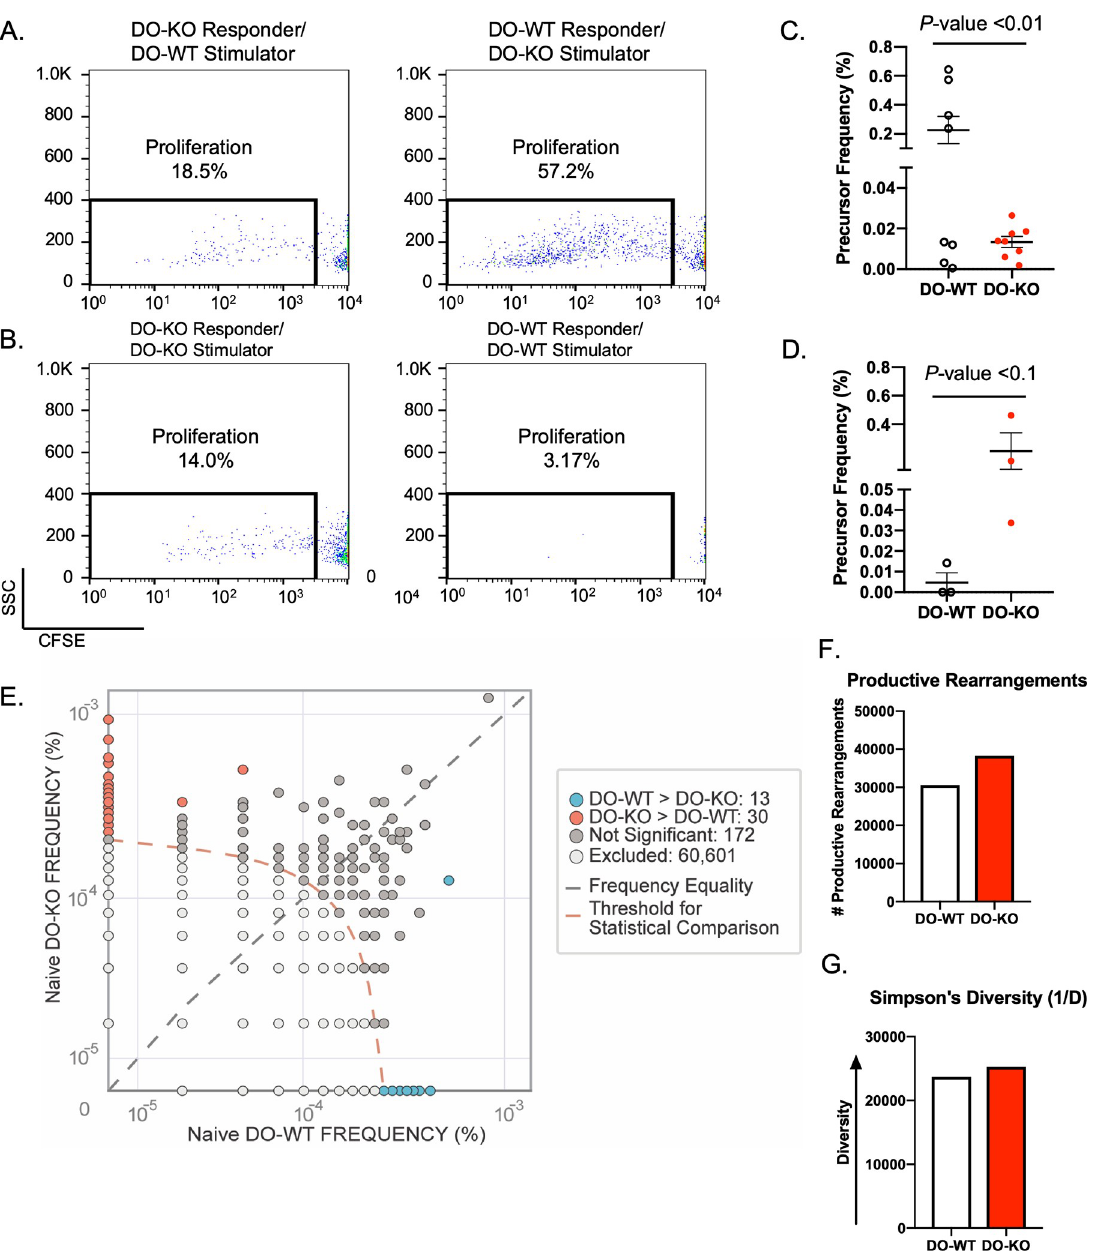
Fig 3. Na ï ve DO-KO mice have a wider T-cell repertoire and are autoreactive. (A) Representative flow plots showing the proliferation of responder CD4 + T cells after stimulation by heterologous B cells. (B) Representative flow plots showing the proliferation of responder CD4 + T cells after stimulation by autologous B cells. (C) PF of responding antigen specific CD4 + T cells in either DO-WT (open) or DO-KO (red) in the modified MLR experiments. N = 8 mice/group (D) PF of responding antigen-specific CD4 + T cells in either DO-WT (open) or DO-KO (red) after autologous B cell stimulation in the modified MLR experiments. N = 3 mice/group. Data are represented as mean ± SEM. (E) TCR β CDR3 sequence comparison of na ï ve CD4 + T cells as determined by next generation sequencing. Dot plot shows the number of TCR β chain sequences that were highly abundant ( > 10 copies/sample, P value < 0.01) in either na ï ve DO-KO (red) or DO-WT (blue) samples. Data are representative of 5 mice pooled per genotype. (F) Total number of productive rearrangements identified in DO-WT (white) or DO-KO (red) samples. (G) Simpson’s Diversity, a measure of species richness or abundance. Experimental results depicted in this figure can be found in S3 Data. CDR3, complementarity-determining region 3; MLR, mixed lymphocyte reaction; PF, precursor frequency; TCR, T-cell receptor.